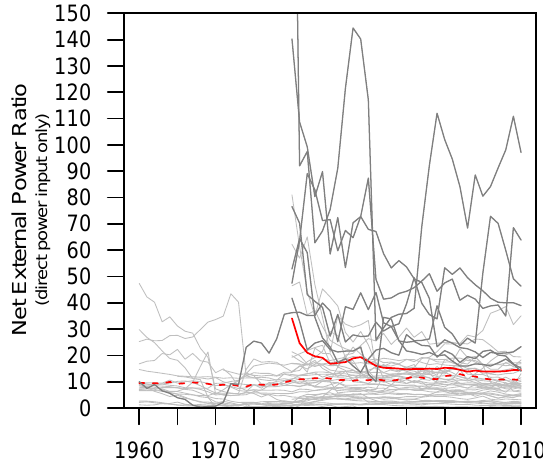
Figure 4. Net external power ratio, NEPR direct , for individual countries (faint gray lines in background) and the weighted world average (solid red line: the energy production-weighted “world” average for all 44 countries from 1980 to 2010; dashed red line: for the 26 OECD countries continuous from 1960). Dark gray lines represent several oil and gas exporting countries (Saudi Arabia, Nigeria, Iran, Iraq, Kuwait, Norway and Libya). Due to data limitations, we cannot estimate NEPR direct from 1960 to 1979 for the non-OECD countries (see the Supplemental